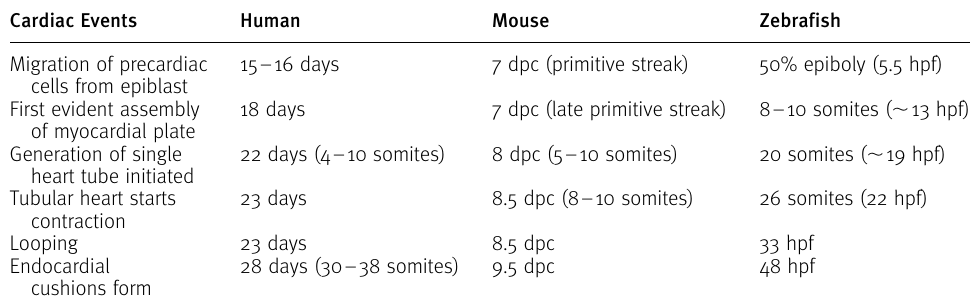
Table 1. Milestones of early heart development shared by different organisms. (modified from 57 ). Cardiac Events Human Migration of precardiac cells from